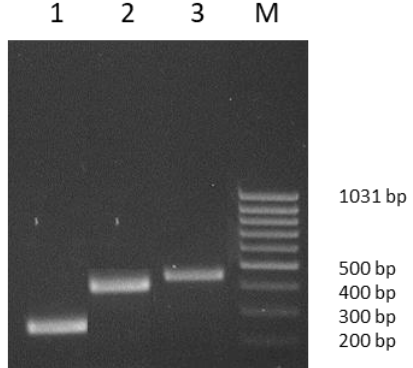
Figure 1. PCR amplicons. Lane 1, 267 bp tet (L) gene fragment; lane 2, 406 bp tet (M) gene fragment; lane 3, 468 bp tet (X) gene fragment; lane M, MassRuler Low Range DNA Ladder, (Thermo Fisher Scientific, Vilnius, Lithuania). Table 3. Tetracycline resistance genes detected in the spleens of wild birds. Spleen